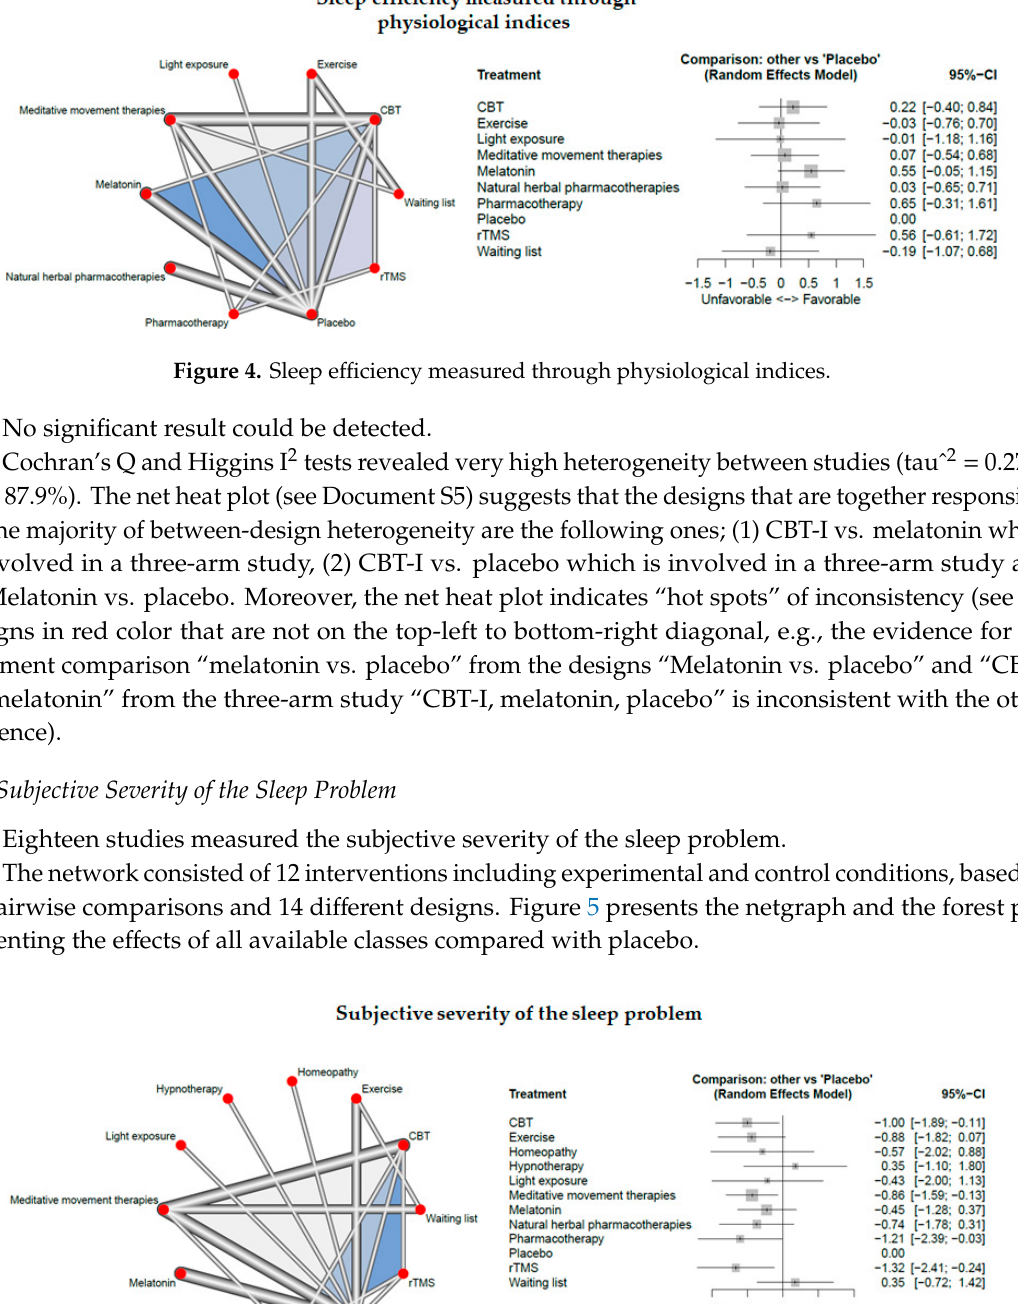
Figure 4. Sleep efficiency measured through physiological indices .